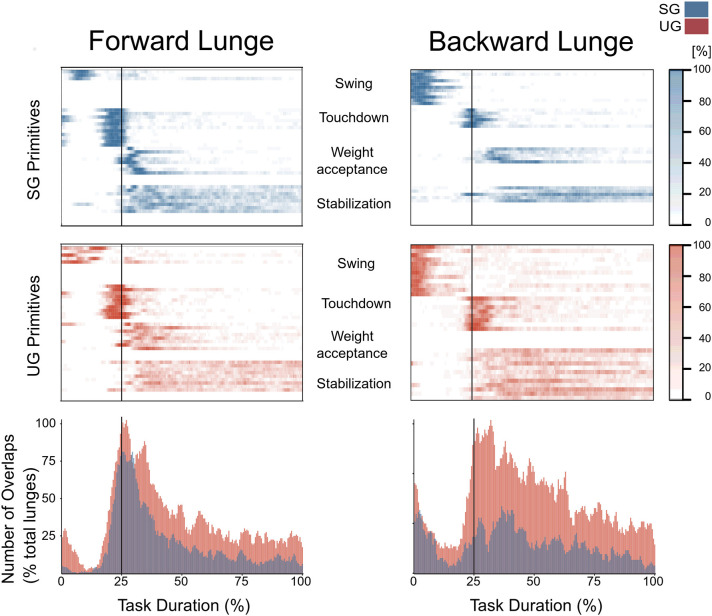
Overlapping time intervals of motor primitives for the forward (left) and backward (right) lunges on stable (SG, top-panel blue) and unstable ground (UG, middle panel red). Each row of the heat maps represents a single motor primitive. A colored time-point indicates the primitive is exceeding half maximum. Darker colors indicate higher number of occurrence across all cycles per participant. At the bottom panel the average number of overlaps across all trials and all participants per ground condition. For all graphs the x-axis full scale represents one trial (from lift-off to steady-state), time-normalized to 200 points. The vertical line indicates the touchdown i.e., the beginning of the double leg stance.